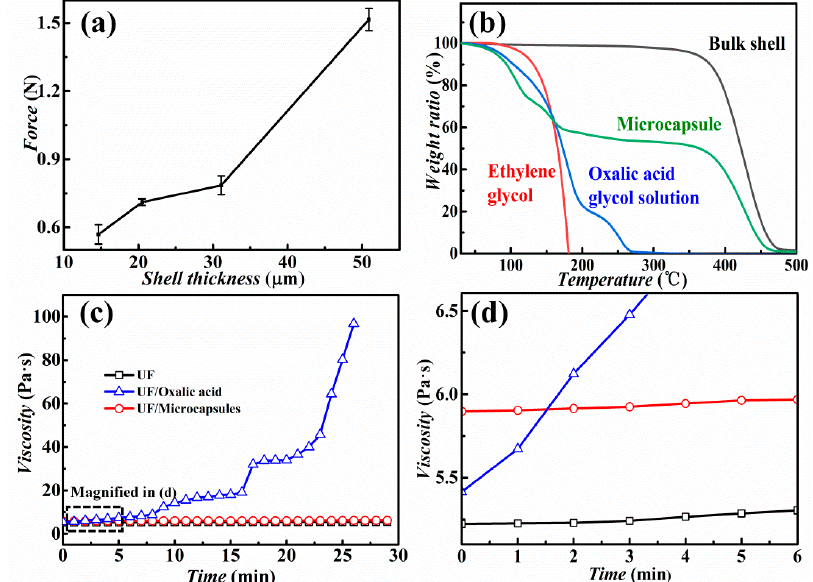
Figure 6. ( a ) Mechanical strength of microcapsules varying with shell thickness. ( b ) Thermogravimetric analysis (TGA) curves of the microcapsules, the bulk shell material, ethylene glycol, and the oxalic acid glycol solution. ( c ) Viscosity change with time for the pure urea–formaldehyde (UF) resin, the mixture of UF resin and oxalic acid, and the mixture of UF resin with microcapsules with oxalic acid cores. ( d ) Enlarged area for close-up view in the dotted rectangle in ( c ).